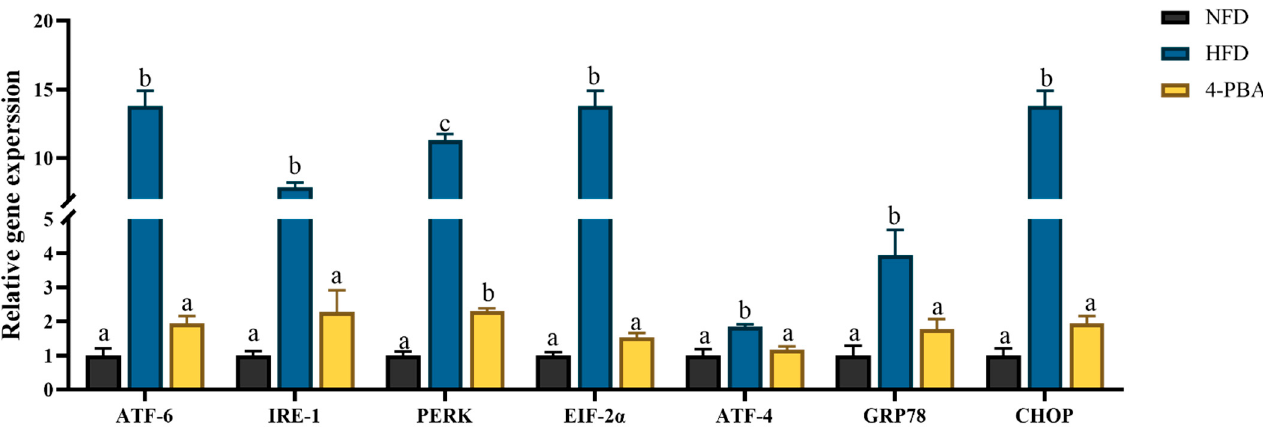
Figure 4. Relative expression levels of ERs-related genes in the livers of L. maculatus that were fed the test diets for eight weeks. All values are exhibited as mean ± SE. The values with different superscripts (a, b, c) are significantly different at p < 0.05 (Tukey’s test).